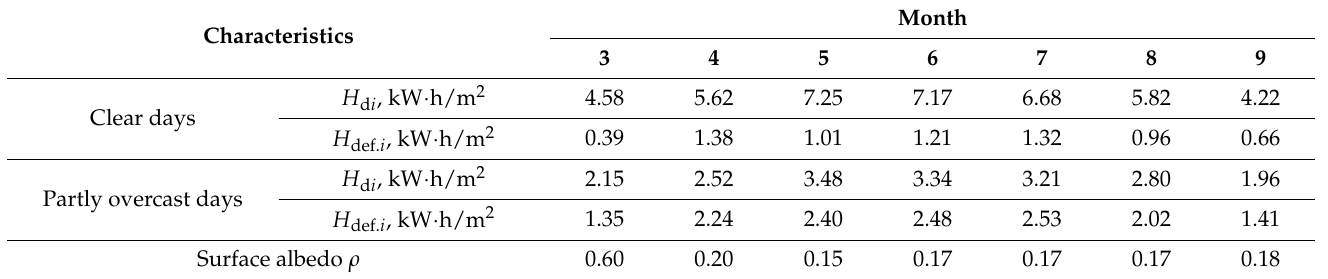
Table 2. Direct and diffuse solar irradiation on horizontal surfaces during a 10 h period (from 07 a.m. to 05 p.m.) on clear and partly overcast days, and surface albedo, ρ , by month. Characteristics